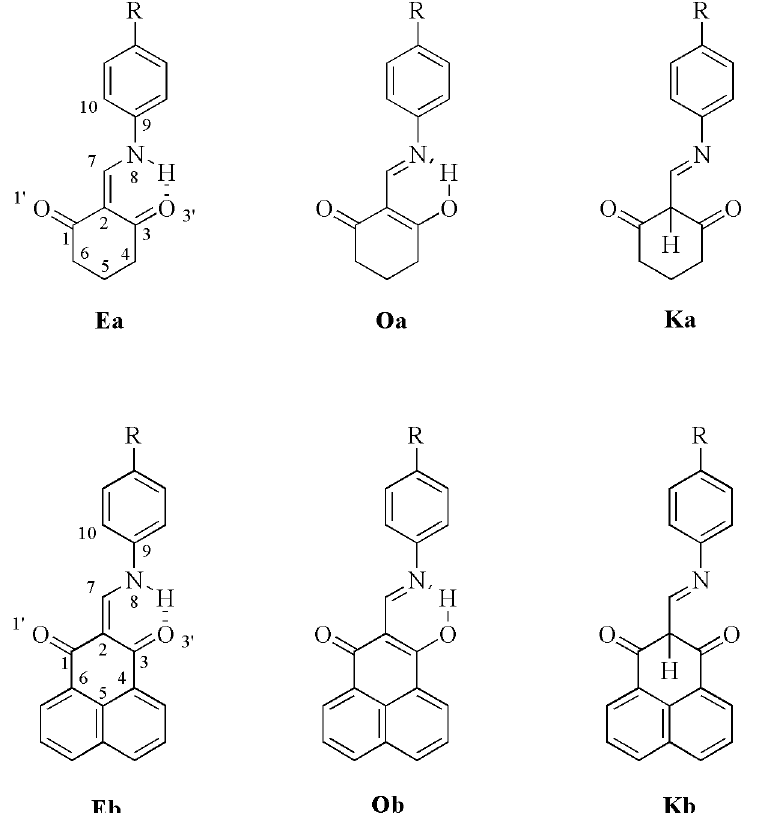
Figure 3. 2-(Anilinemethylidene)cyclohexane-1,3-diones, 2-(anilinemethylidene)-2 H -phenalene-1,3-diones, and their tautomers (R = OMe ( 1 ), Me ( 2 ), H ( 3 ), Cl ( 4 ), NO2 ( 5 )).